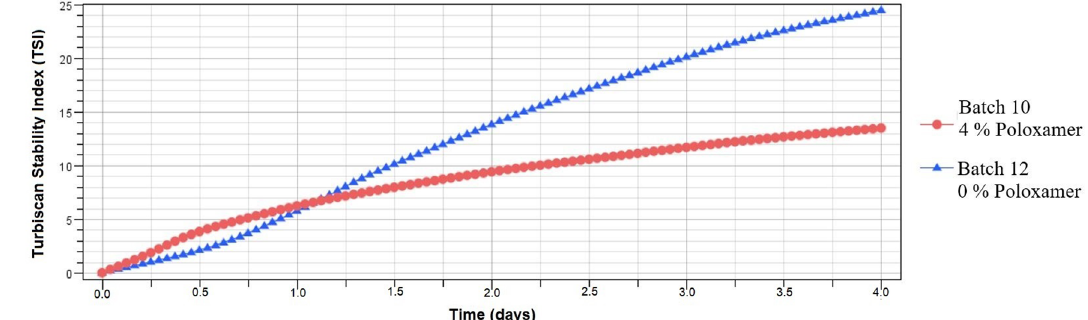
Figure 9. Kinetic stability comparison of Batch 10 and Batch 12. Figure 10. Poloxamer molecular structure.